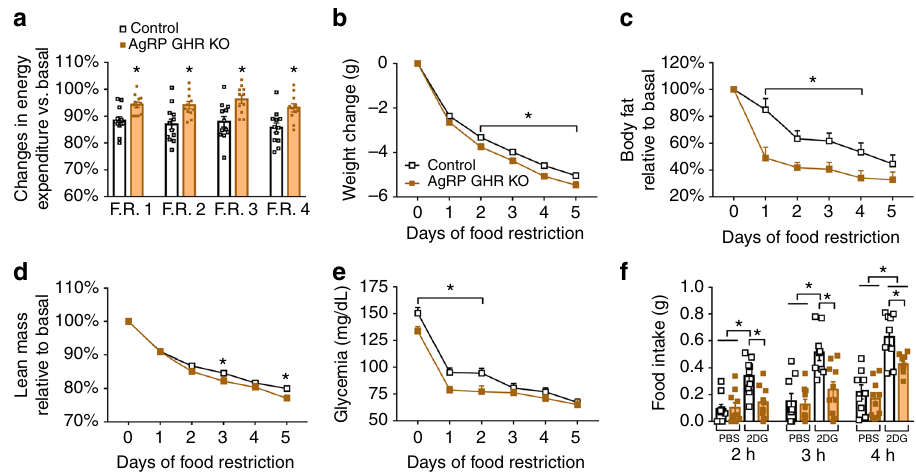
Fig. 4 Energy-conserving effects of growth hormone (GH) signaling in agouti-related protein (AgRP) neurons. a Reduction in energy expenditure (VO 2 ) during food restriction (F.R.) compared to baseline (F.R. 1, t (22) = 3.296, P = 0.0033; F.R. 2, t (21) = 2.913, P = 0.0083; F.R. 3, t (21) = 3.223, P = 0.0041; F.R. 4, t (21) = 3.144, P = 0.0049; n = 11 – 12; unpaired t -test). b Changes in body weight (main effect of F.R. [ F (5,225) = 1525, P < 0.0001], main effect of growth hormone receptor (GHR ablation [ F (1,45) = 7.077, P = 0.0108] and interaction [ F (5,225) = 3.251, P = 0.0074]; control = 25; AgRP GHR KO = 22). c Body fat mass (main effect of F.R. [ F (5,60) = 29.23, P < 0.0001], main effect of GHR ablation [ F (1,12) = 11.27, P = 0.0057] and interaction [ F (5,60) = 2.079, P = 0.0805]; control = 5; AgRP GHR KO = 9). d Lean body mass (main effect of F.R. [ F (5,60) = 526.9, P < 0.0001], main effect of GHR ablation [ F (1,12) = 3.429, P = 0.0888] and interaction [ F = 3.026, P = 0.0168]). e Blood glucose changes during F.R. (main effect of time [ F = 88.32, P < 0.0001], (5,60) (5,158) main effect of GHR ablation [ F (1,158) = 19.45, P < 0.0001] and interaction [ F (5,158) = 1.463, P = 0.205]; n = 14 – 15) and Fisher's least signi fi cant difference (LSD) post-hoc test (* P < 0.01). f Food intake after intraperitoneal (i.p.) injection of either phosphate-buffered saline (PBS) or 2-deoxi- D -glucose (2DG; 0.5 mg/kg body weight (b.w.); n = 9 – 10). The effects of F.R. or 2DG were analyzed by two-way analysis of variance (ANOVA). All results were expressed as mean ±